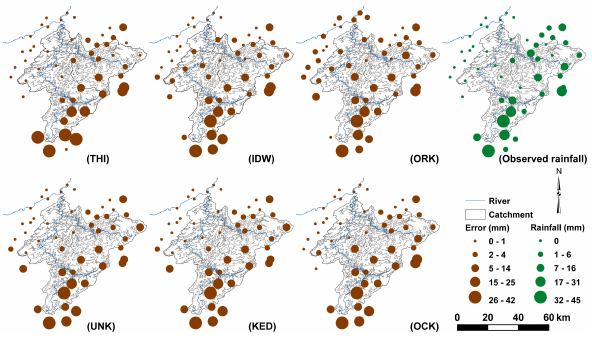
Fig. 14. Comparison between Kriging using seven variogram mod- els (blue line) and Kriging using only spherical variogram model and simply setting negative rainfall to zero (red